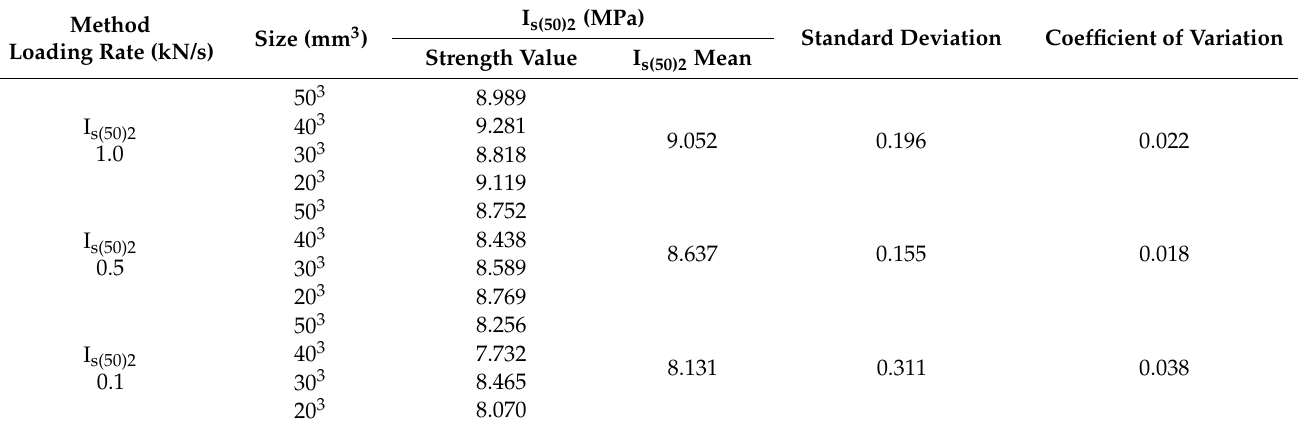
Table 6. Statistical table listing the variability of I s(50)2 for coarse-crystalline granite with different sizes and loading rates.